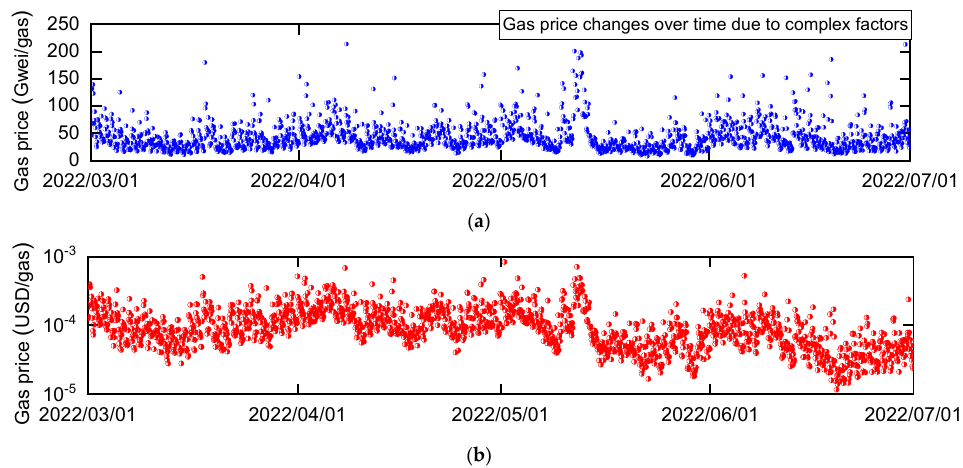
Figure 5. Time variation in gas price on Ethereum’s main network. The transaction fee is determined by the gas price and gas usage. Gas prices change over time due to various factors. Gas usage depends on the throughput of smart contracts (type and number of opcodes executed). ( a ) Gas price (Gwei/gas). ( b ) Gas price (USD/gas).